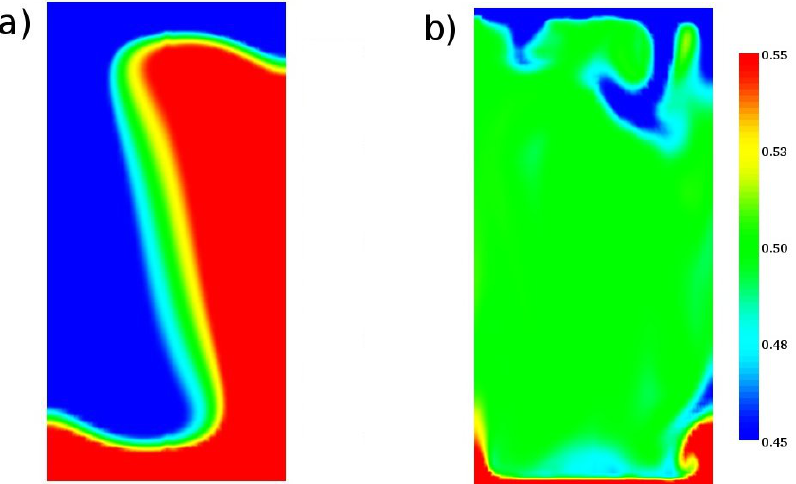
Figure 10. Temperature plot on the vertical plane ( θ = 0): ( a ) Flow without bubble; ( b ) flow with bubble (two-way